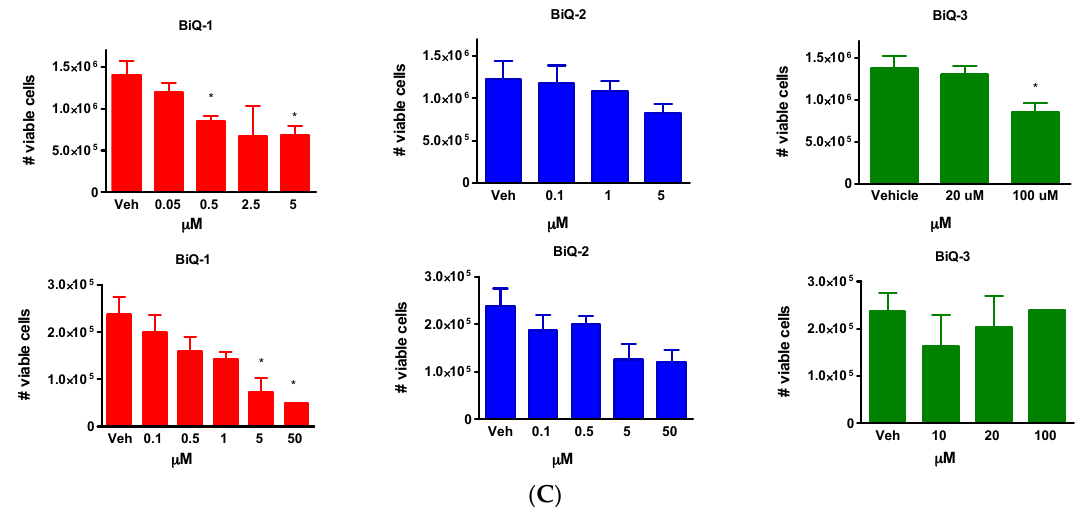
Figure 1. ( A ) Structures of BiQ-1, BiQ-2 and MonoQ; ( B ) MOLM-14 and THP-1 cells as well as AML-A, AML-B, AML-C and normal bone marrow cells from a healthy donor were exposed to a range of BiQ-1 concentrations. Cells were cultured in the presence of BiQ-1 for 72 h (48 h for primary cells) and Alamar Blue reagent was then added. The representative growth inhibition curves for each cell are shown in this Figure. Mean ± standard deviation IC 50 values are shown in Table 1; ( C ) BiQ-1 inhibits AML cell growth regardless of FLT3 mutation status. Cell survival after BiQ exposure was determined via trypan blue exclusion. MOLM-14 and THP-1 were treated with BiQ-1, BiQ-2 or MonoQ at serial concentrations for 72 h. Both BiQ-1 and BiQ-2 induced a concentration-dependent reduction in cell survival, while only a slight, non-significant, decrease in viable cells was observed even with 100 µM MonoQ in the MOLM-14 cells (* p < 0.05). Only BiQ-1 produced a statistically significant decrease in cell numbers at its IC 50 concentration in the trypan blue exclusion assay (* p < 0.05). Table 1. IC 50 values of BiQ-1, BiQ-2, and MonoQ in leukemia cell lines and primary AML cells isolated from patients, and normal bone marrow cells. Cell Line BiQ-1 (µM)